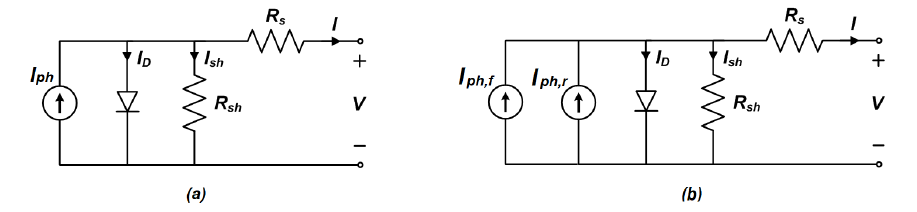
Figure 3. Solar cell equivalent electric circuit that represents the electrical performance solar cells. ( a ) Equivalent circuit of a monofacial PV solar cell, ( b ) Equivalent circuit of a bifacial PV solar cell. For this model, Equation (3) represents the current-voltage relation of a silicon PV cells connected in series forming a PV